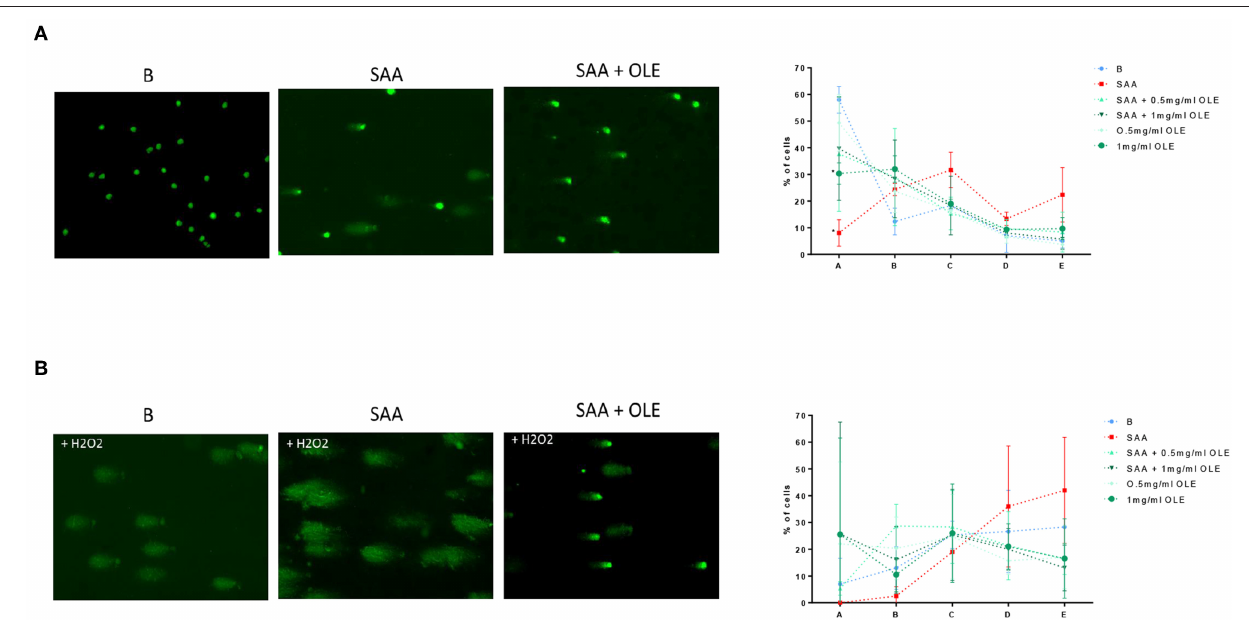
FIGURE 4 | OLE attenuates SAA-induced and H 2 O 2 -induced DNA damage in HCAEC. COMET assay was performed without (A) and with oxidative treatment (3% H 2 O 2 ) (B) . Average from 3 biological replicates of the COMET assay for each experimental condition was performed on duplicate slides, 100 cells were evaluated per slide according to the following categories: A - no tail (no DNA damage), B - slight tail, C - strong signal in tail, but also in nucleus, D - majority of DNA in tail, E - no DNA in round